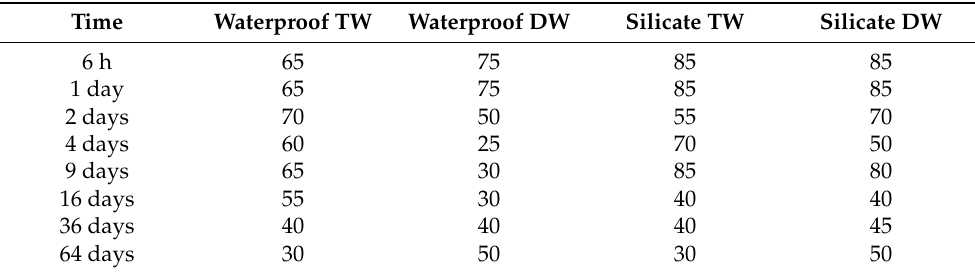
Table 2. Avoidance results percentages (%) for E. albidus, calculated for all eluates of waterproof and silicate.